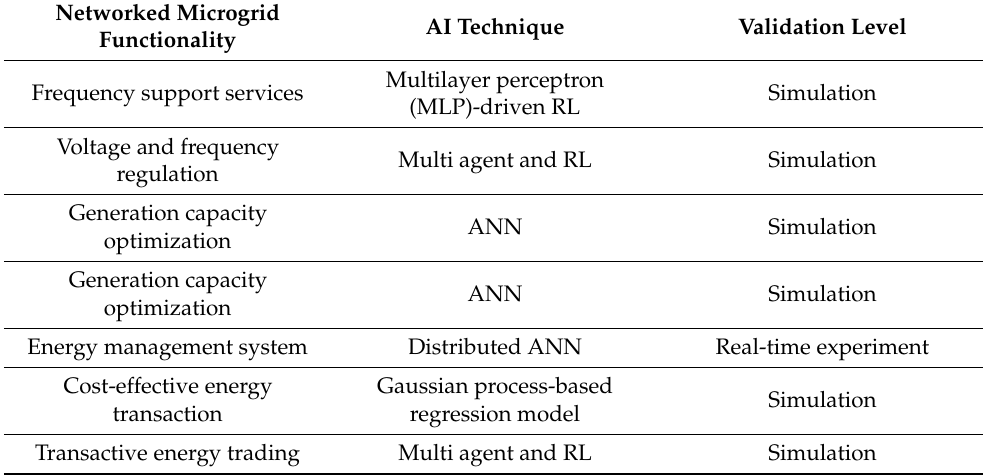
Table 1. Related control algorithms level